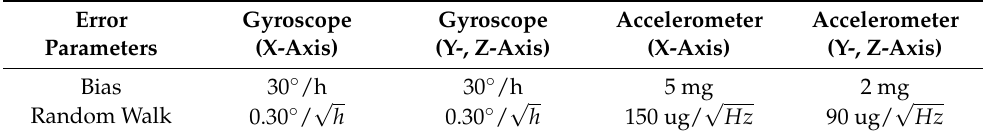
Table 9. Parameters of the sensors in